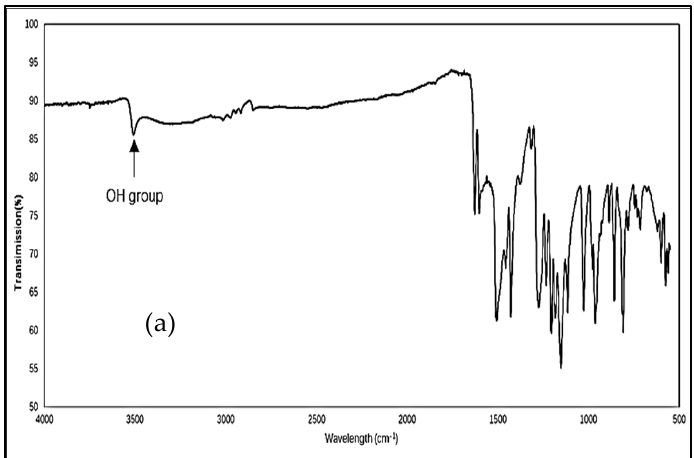
Table 2. Saturation solubility of curcumin from Formulation A, Formulation B and commercial curcumin in pH 6.8 buffer ( n = 3, mean ±